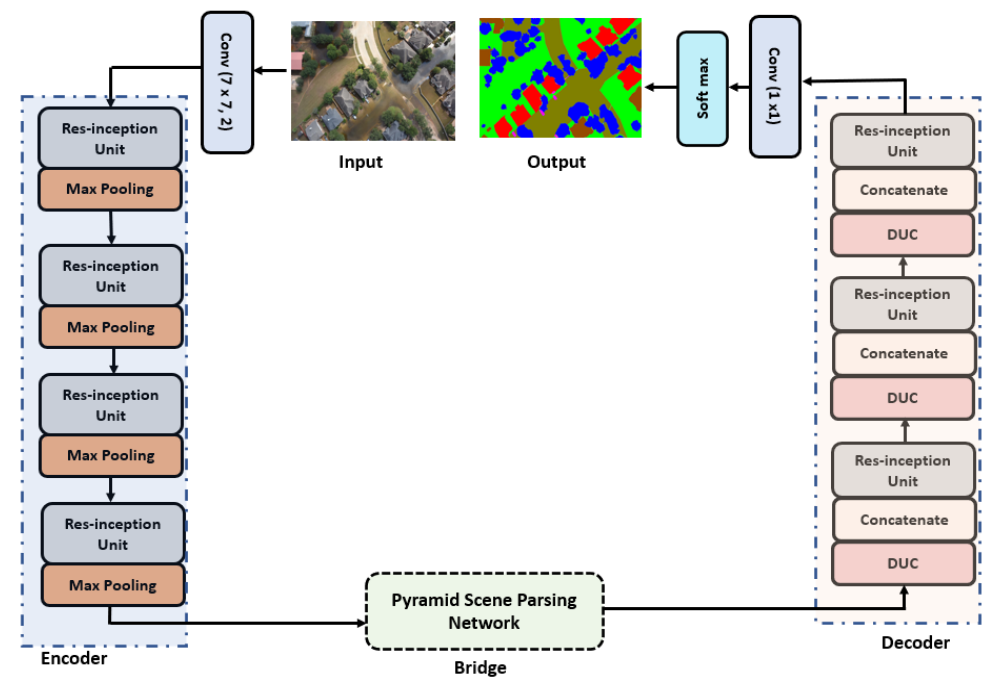
Figure 1. Detailed architecture of proposed framework for flood segmentation in satellite